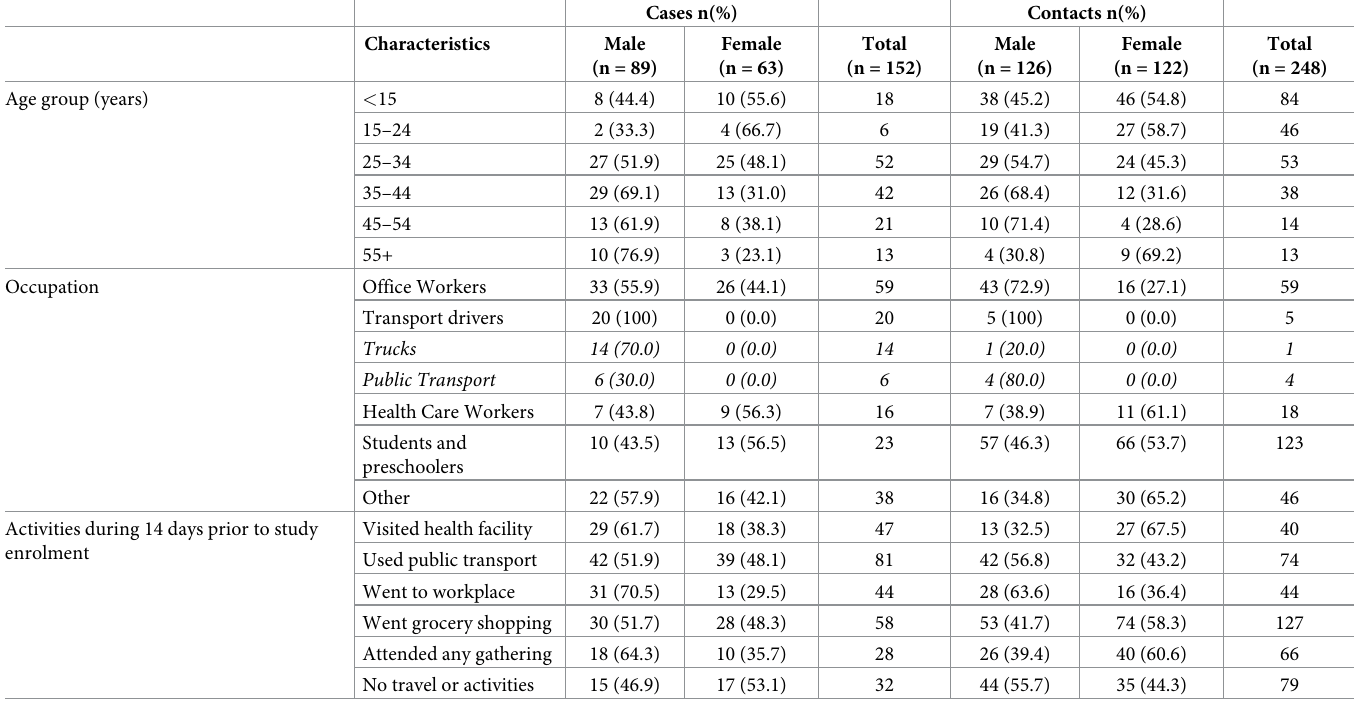
Table 1. Demographic profile of COVID-19 cases and contacts, FFX study, Kisumu, Kenya, June-October